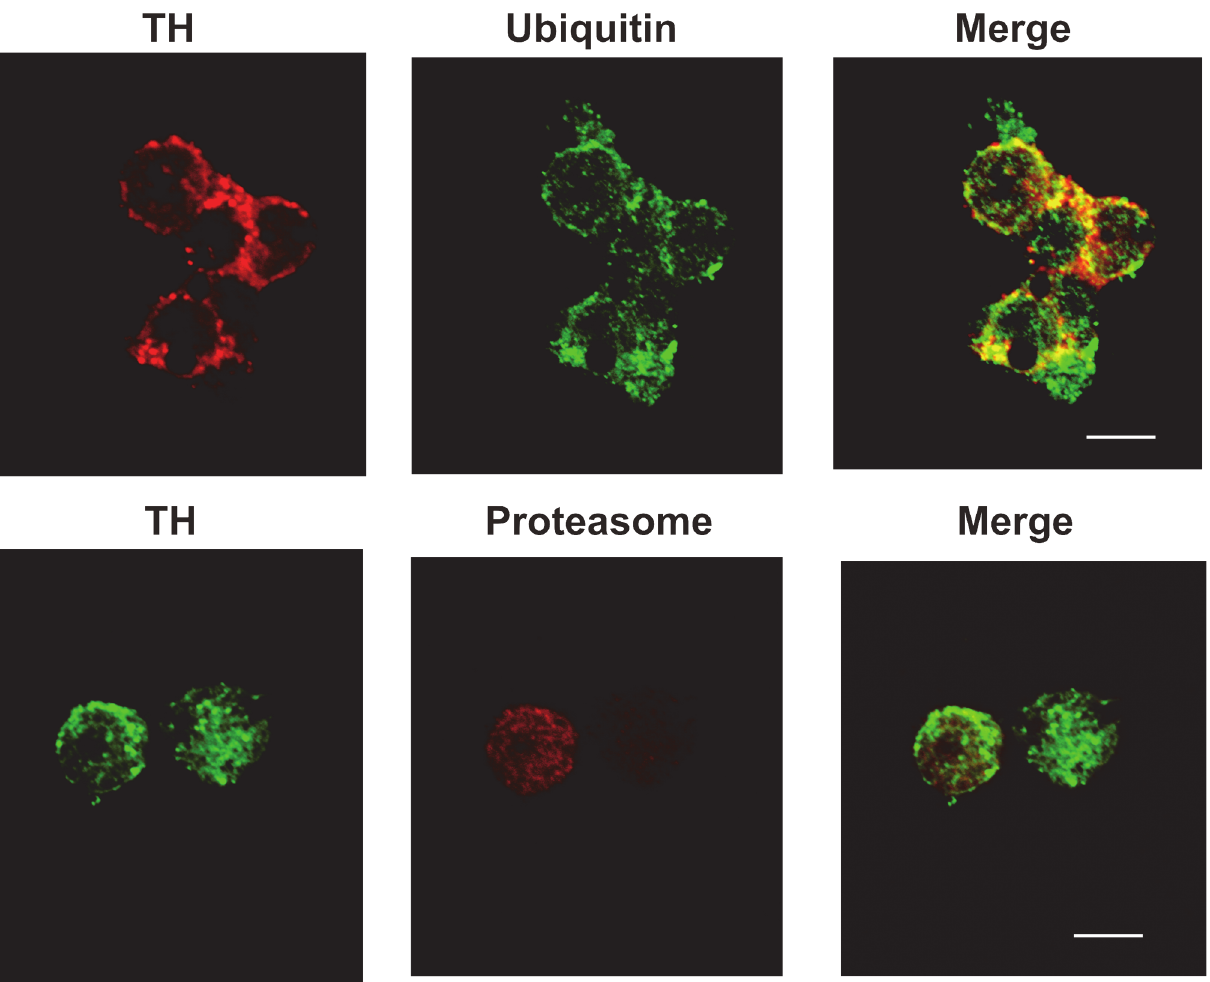
Fig 3. Colocalization of TH with ubiquitin or proteasome in PC12 cells. Cells were incubated with either mouse anti-TH plus rabbit anti-ubiquitin antibodies (upper panel) or rabbit anti-TH plus mouse anti-proteasome antibodies (lower panel) followed by incubation with a anti-rabbit antibody coupled to Alexa 488 and anti-mouse coupled to AlexaFluor 594. See text for details. Scale bar = 5 μ m. Three separate cell culture preparations were performed and 10 different images were taken and analyzed for each experiment. One representative image is